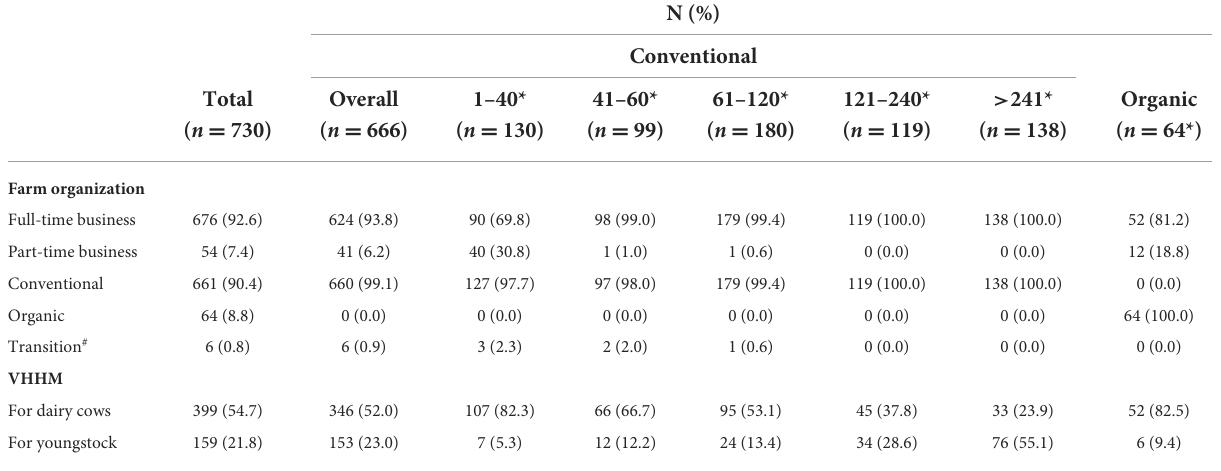
TABLE 2 Farm organization and the use of veterinary herd health management (VHHM) advisory services on 730 dairy farms in Germany stratified by herd size and farm type.